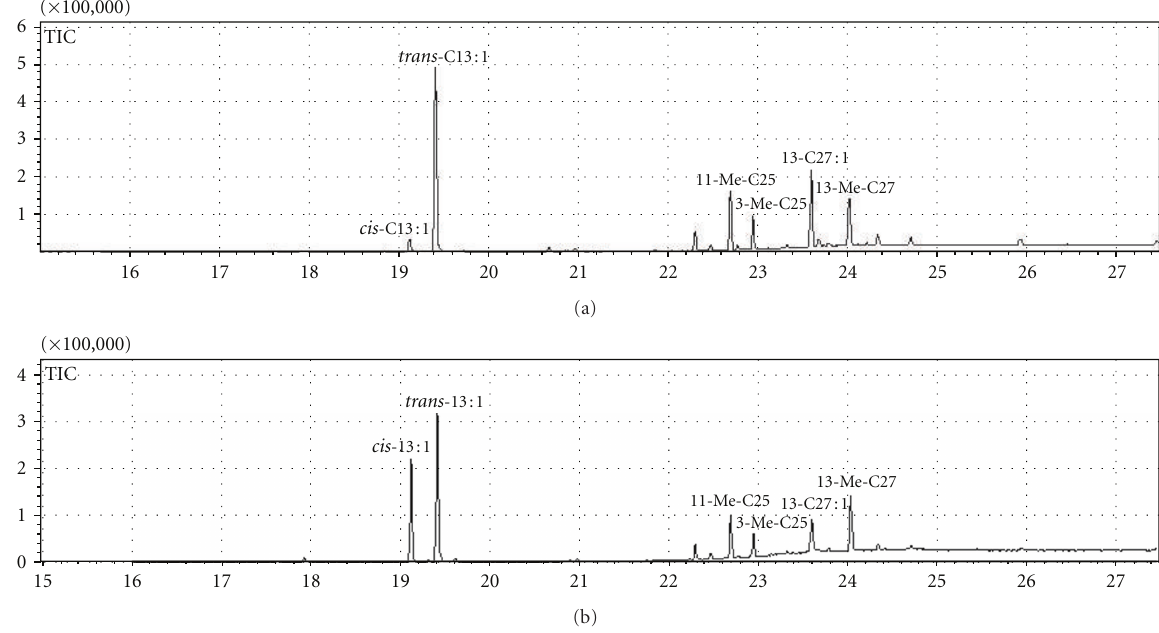
Figure 4: Total ion current chromatograms of body washes of workers of Solenopsis saevissima variety A from Rio de Janeiro, Brazil: (top) Minor workers; (below) Major